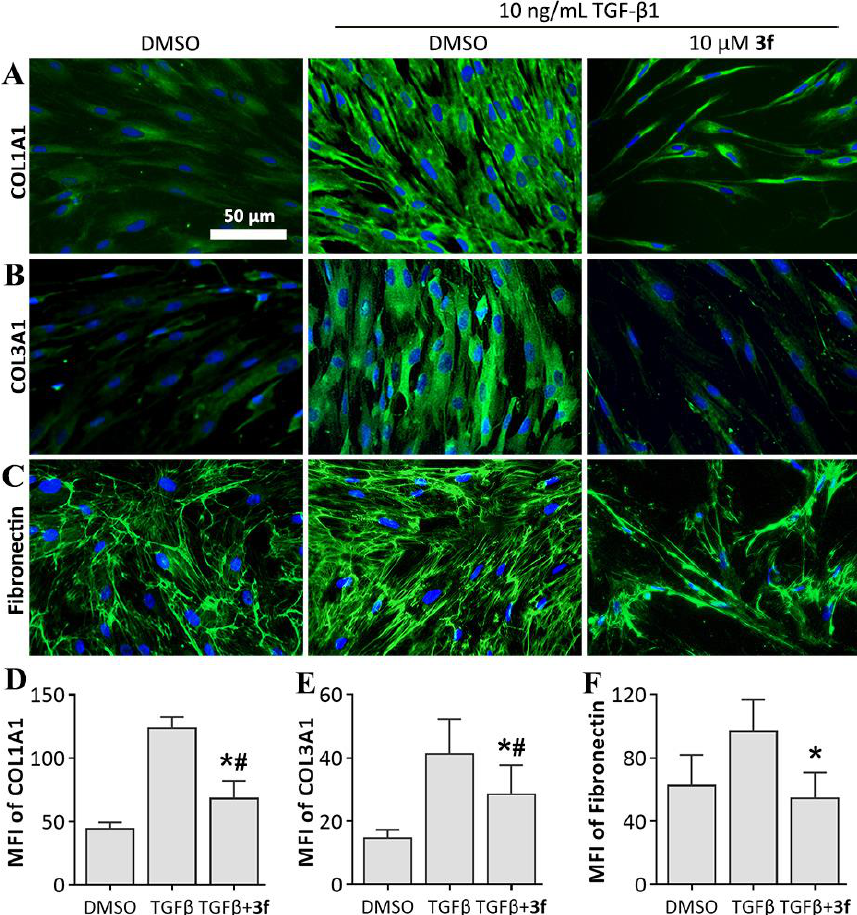
Figure 4. Effects of compound 3f on inhibiting extracellular matrix (ECM) protein levels in MRC-5 cells. ( A – C ) Immunofluorescence staining of each protein; ( D – F ) Mean fluorescence intensity (MFI) of each protein, presented as mean ± SD of three individual experiments. * p < 0.05 vs TGF β group, # p < 0.05 vs. DMSO group.